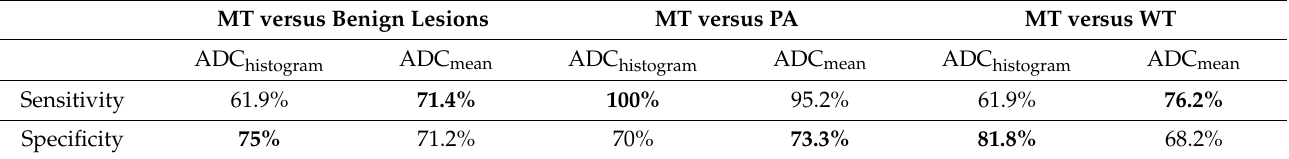
Table 3. Sensitivity and specificity results (bold numbers indicate superior